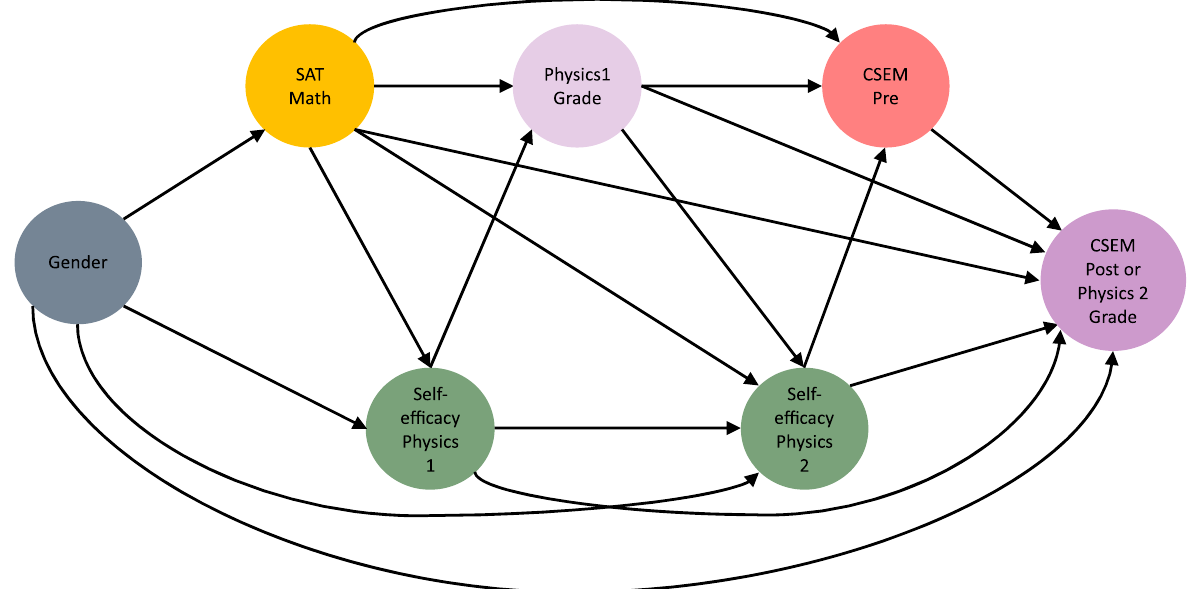
FIG. 1. Conceptual framework connecting gender to learning outcomes (conceptual post-test and Physics 2 course grade) via key college academic experience (Physics 1 grade), attitude (self-efficacy in Physics 1 and 2 at the beginning of the semester in each case), and prior knowledge or skill variables (SAT Math and conceptual pretest CSEM scores). Each arrow corresponds to a linear regression relation between two variables within the path analysis using